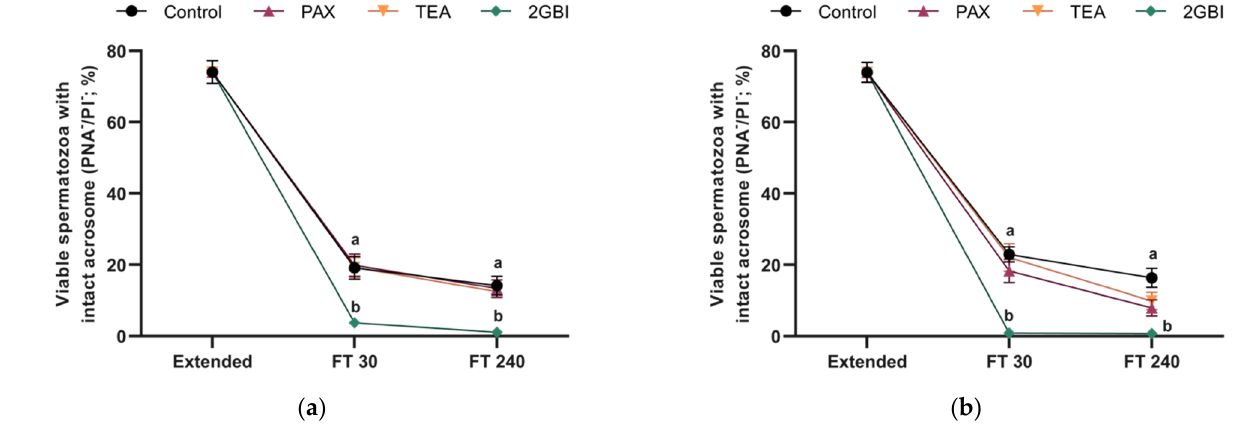
Figure 4. Percentages of viable spermatozoa with an intact acrosome in extended and frozen-thawed (FT) samples at 30 min and 240 min post-thaw. In experiment 1 ( n = 8), TEA, PAX, and 2-GBI blockers were added to LEY medium at 15 °C ( a ), whereas in experiment 2 ( n = 9), they were added to LEYGO medium at 5 °C ( b ). Different superscripts indicate significant differences ( P < 0.05) between samples within the same time point. Results are given as mean ± SEM.